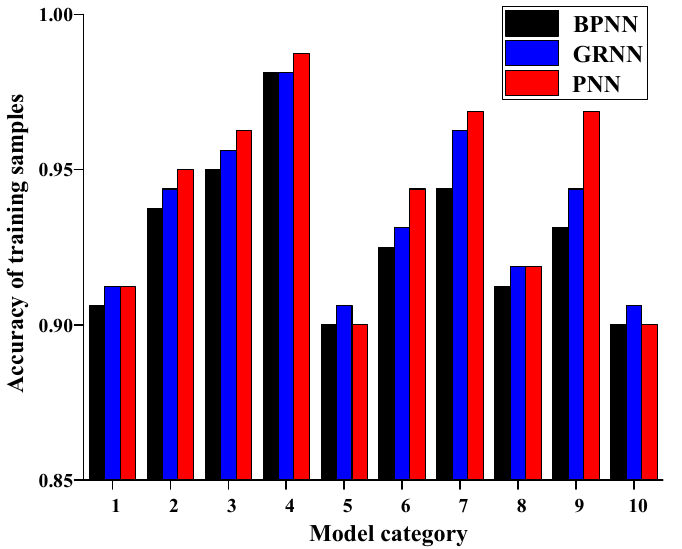
Figure 9. Accuracy comparison of training samples of different input models and different classifiers.